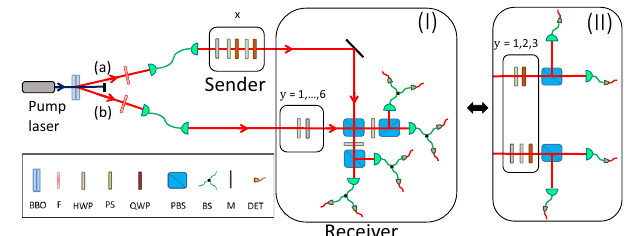
Fig. 2 | Experimental setup . Ultraviolet light centred at a wavelength of 390nm is focused onto two 2mm thick β barium borate (BBO) nonlinear crystals placed in cross-con fi guration to produce photon pairs emitted into two spatial modes ( a ) and ( b ) through the second order degenerate type-I SPDC process. The spatial, spectral, and temporal distinguishability between the down-converted photons is carefully removed by coupling to single mode fi bre, narrow Filter (F) and quartz (cid:1) .Theunitariesofthesenderandreceiverare wedgesrespectivelyandprepare ∣ ϕ + implemented using combination of half wave plates (HWP), quarter wave plates (QWP) and phase shifters (PS). (I) The partial Bell state measurements are imple- mented through two-photon interference, using PBS and HWP plates set at 22.5 ∘ . Beam splitters (BS) are introduced to estimate the projection probabilities before single photon detectors (actively quenched Si-avalanche photodiodes, DET). Out- (cid:1) ,andoutcome b = − 1corresponds come b =+1correspondstoprojectiononto ∣ ϕ + (cid:1) (cid:1) (cid:1) , ∣ ψ + ,and ∣ ϕ (cid:4) totheotherBellstates ∣ ψ (cid:4)